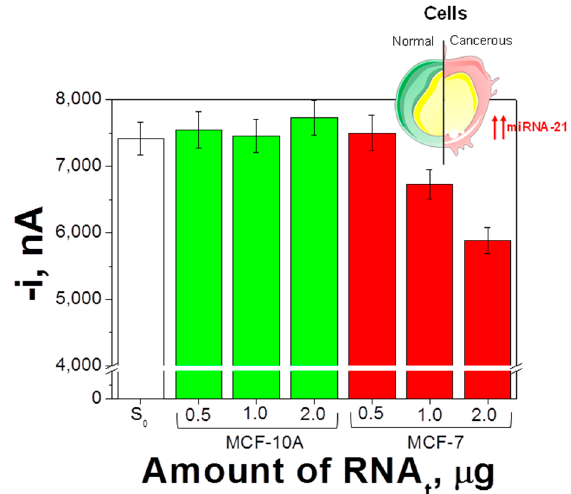
Figure 5. Determination of the endogenous content of miRNA-21 in raw total RNA (RNA t ) extracted from breast cells. Amperometric responses measured with the developed biosensor in the absence (S 0 ) and in the presence of different amounts of RNA t extracted from MCF-10A and MCF-7 cells. Error bars estimated as three times the standard deviation of three replicates.